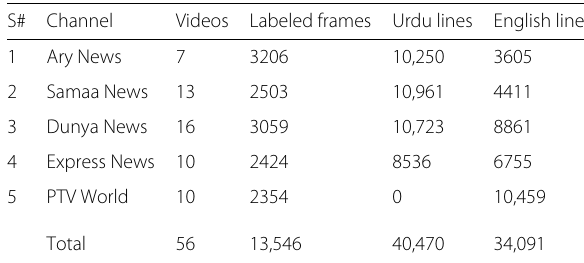
Table 1 Channel videos and video image